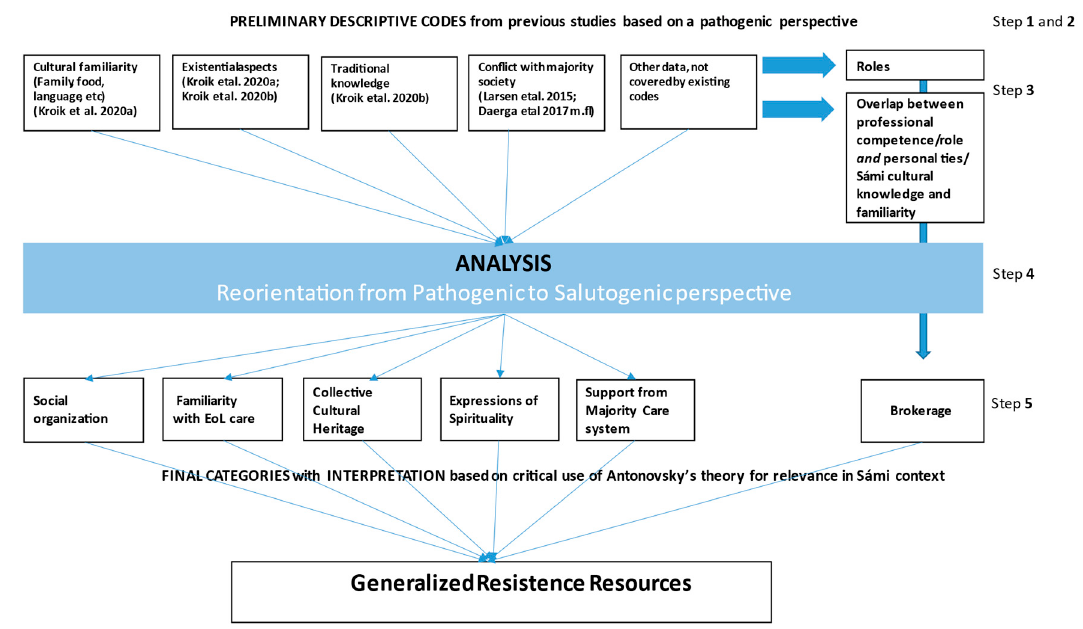
Figure 1. Graphic description of the analytic process.